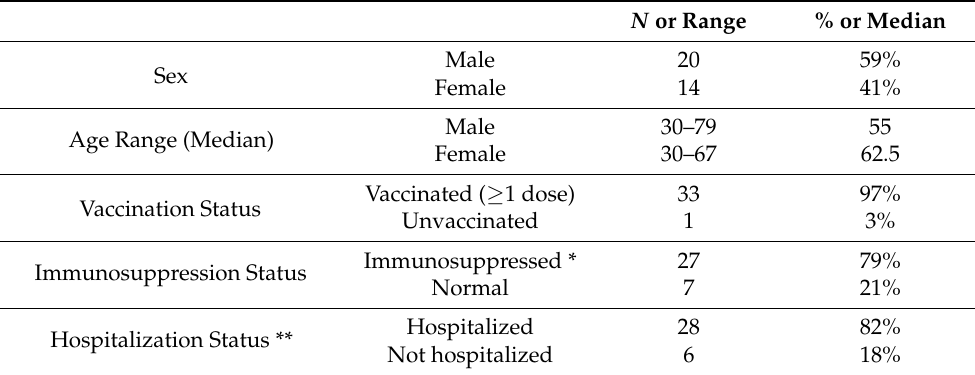
Table 2. Summary of patient demographics ( n = 34). Sex